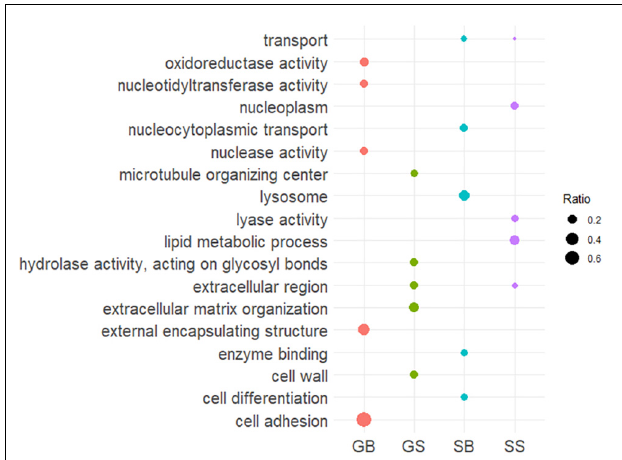
FIGURE 5 | Screen for biological process enrichment: first five most enriched processes for both biased and specific genes (GOseq p < 0.05 with Wallenius correction for multiple testing). Size of the circle correspond to the ratio of terms associated with a GO slim in that category of gene expression relative to all terms in that